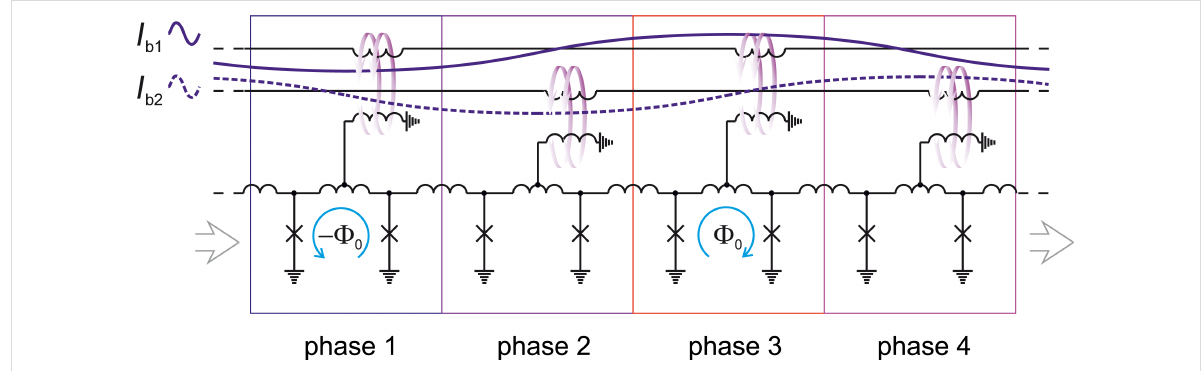
Figure 9: RQL transmission line with four-phase bias. I b1,b2 are ac bias currents providing the power supply and acting as clock signal. The blue arrows show SFQ currents, violet arrows present magnetic coupling.